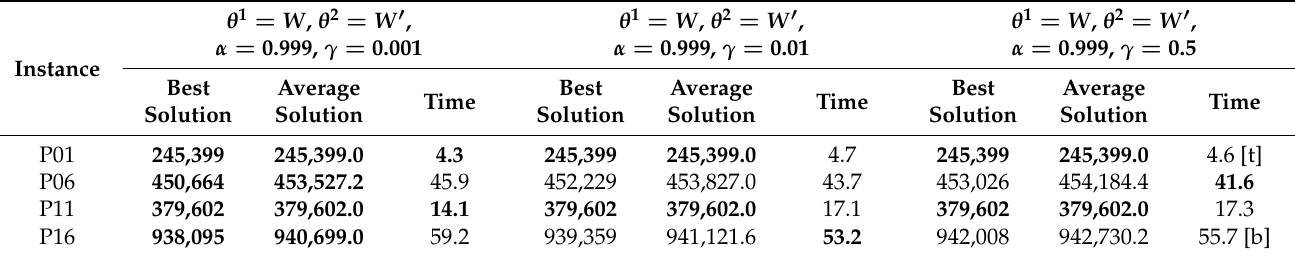
Table 5. The result of instances by HCDBAVNS with different γ .